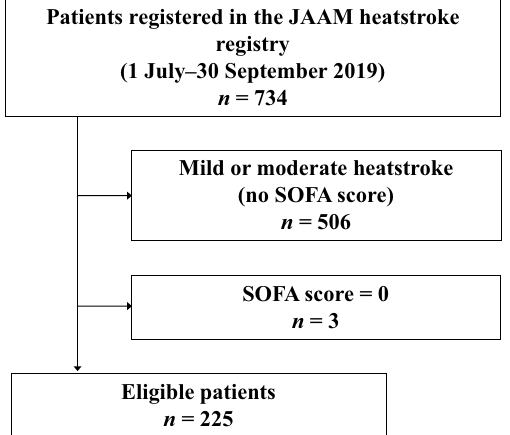
Figure 1. Patient disposition a total of 225 patients were considered eligible for this study after excluding patients with no SOFA score or a SOFA score of 0. JAAM, Japanese Association of Acute Medicine; SOFA, Sequential Organ Failure